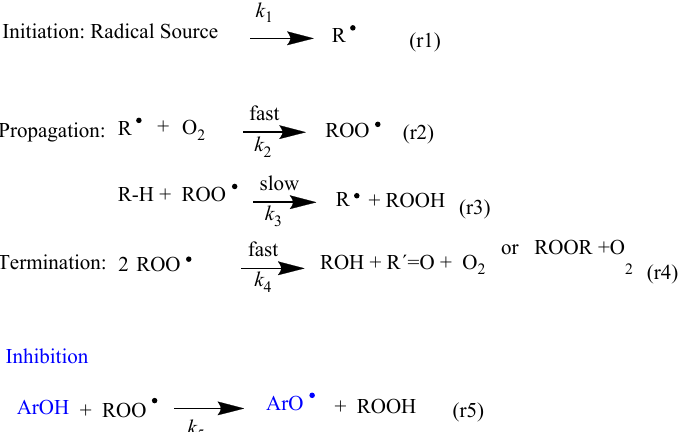
Scheme 2. Basic steps (r1–r4) of the chain reaction in the oxidation of an unsaturated lipid (R-H). The inhibition reaction (r5) takes place upon the transfer of an H atom of a phenolic antioxidant (ArOH) to